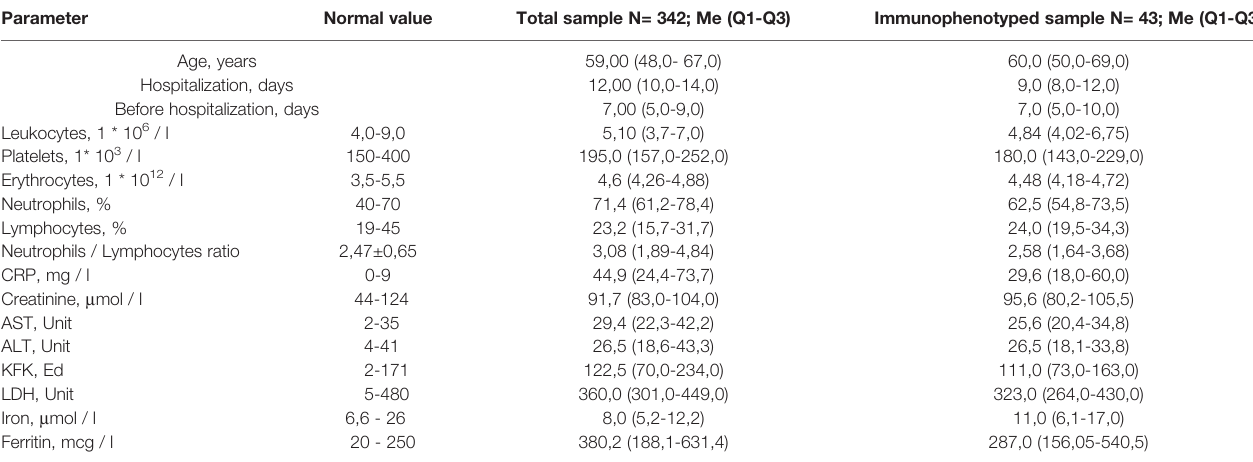
TABLE 1 | Basic characterisation of total COVID-19 patients ’ cohort and cohort selected for the lymphocyte analysis. Parameter Normal